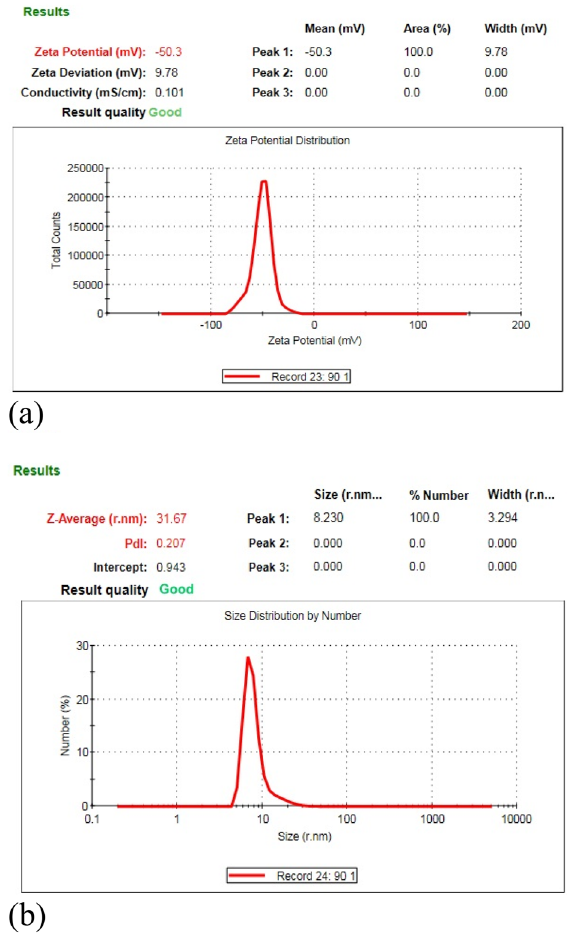
Figure 4. AgINC ( a ) zeta potential and ( b ) size distribution.